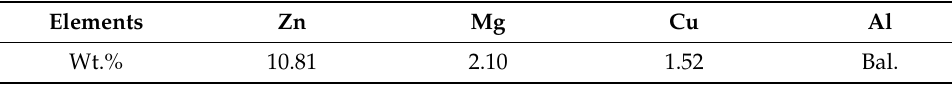
Table 1. Chemical composition of the Al-Zn-Mg-Cu